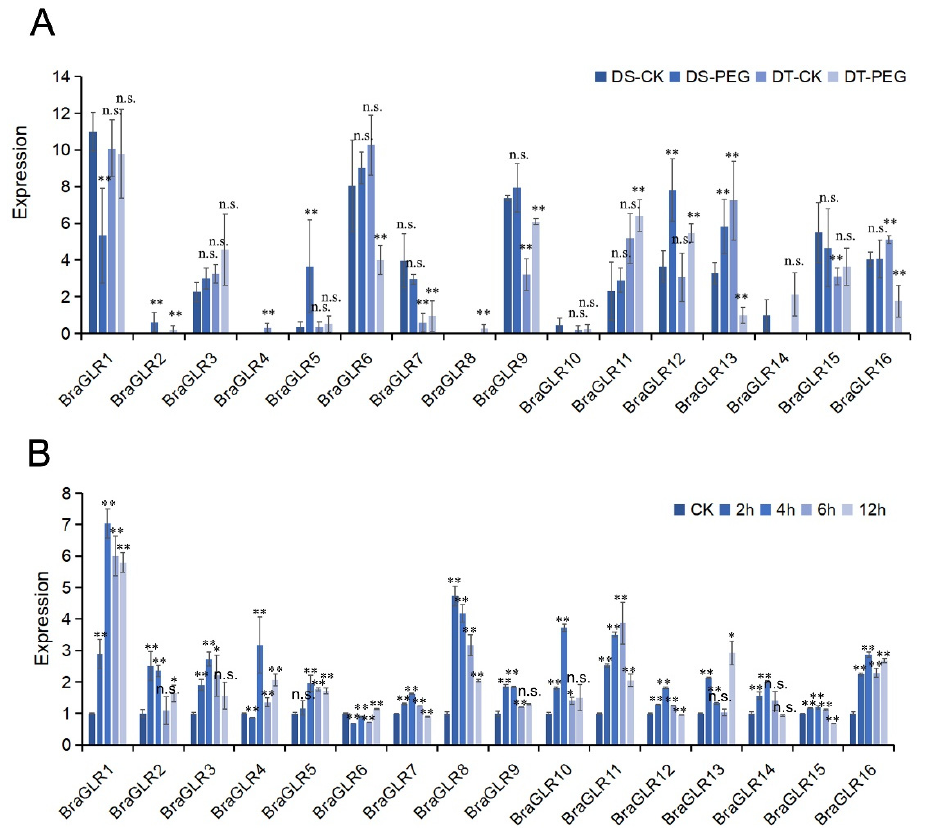
Figure 6. Analysis of abiotic stress transcript levels of GLR genes in B. rapa . ( A ) Analysis of drought stress transcriptome data of GLR genes in B. rapa . PEG treatment for drought-tolerant and drought-sensitive plants, denoted by DT-PEG and DS-PEG, respectively. ( B ) Analysis of salt stress relative expression of GLR genes in B. rapa by qRT-PCR. Eleven-day-old seedlings were treated with 150 mmol L − 1 NaCl, followed by sampling at 0 (CK), 2, 4, 6, and 12 h. (n.s., no significance, * p < 0.05, ** p < 0.01, t test).